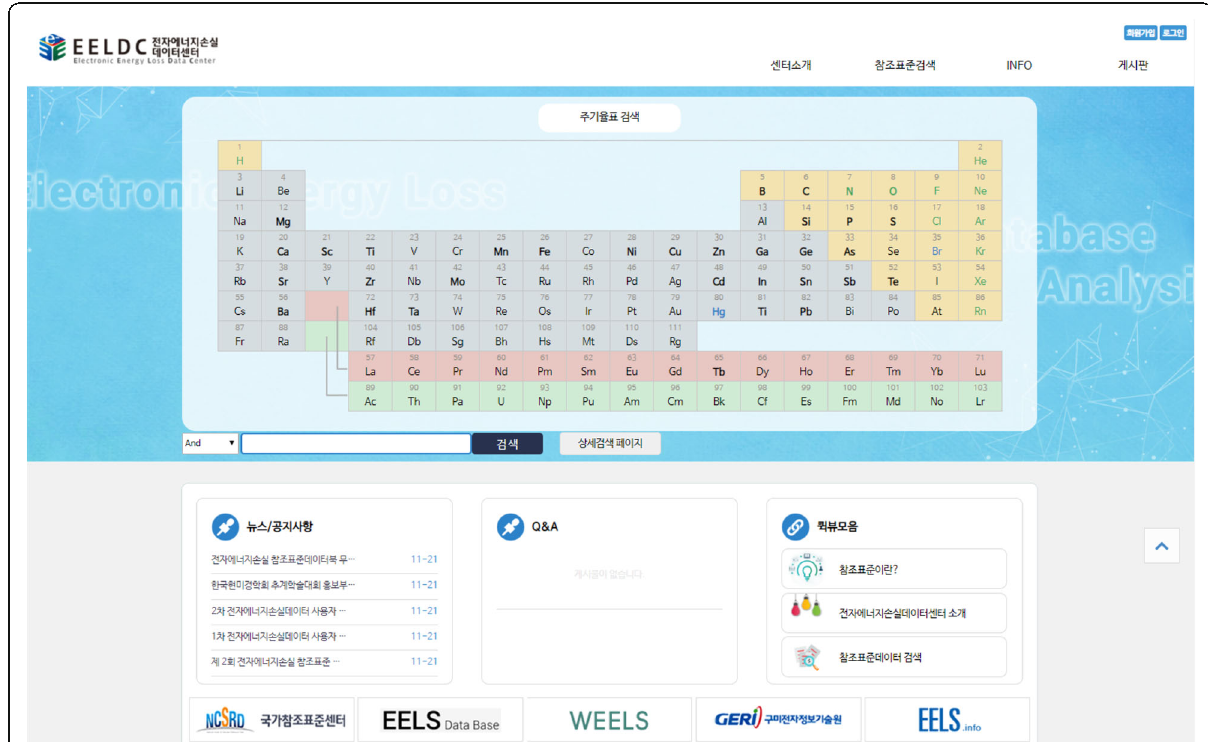
Fig. 1 Main page of Electron Energy Loss Data Center (EELDC) website